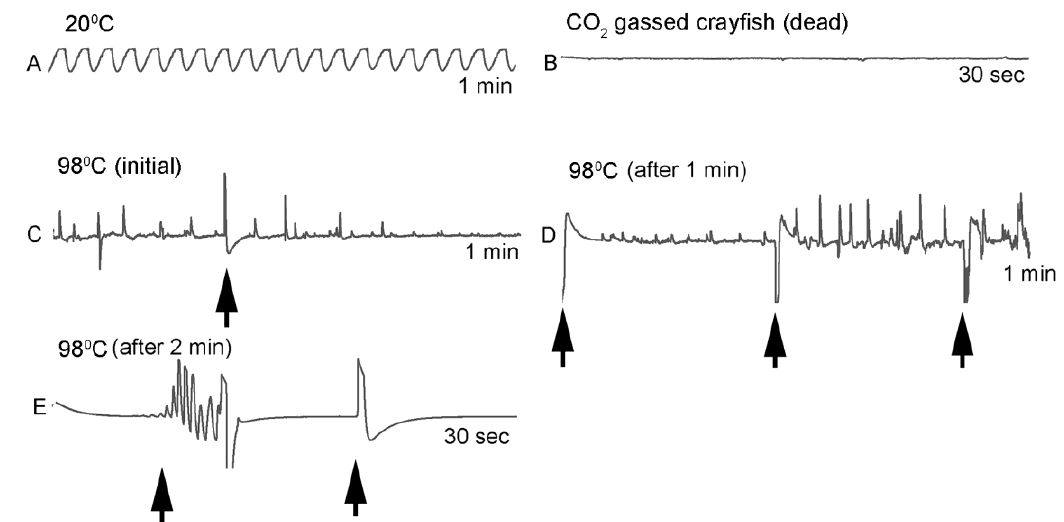
Figure 9. Impedance measures of a single crayfish. ( A ) Impedance measure of the heart rate in the live crayfish for 1 min at 20 °C. ( B ) A 30 s impedance measure of the heart rate of the crayfish after being euthanized with CO 2 . ( C ) Impedance measure of the dead crayfish placed in boiling water in the first min for 1 min and ( D ) after 1 min. ( E ) After 2 min in boiling water the impedance traces flatlined. The arrows shown represent artifacts from re-zeroing the impedance detector while recording. The sequence of events is in alphabetical order.